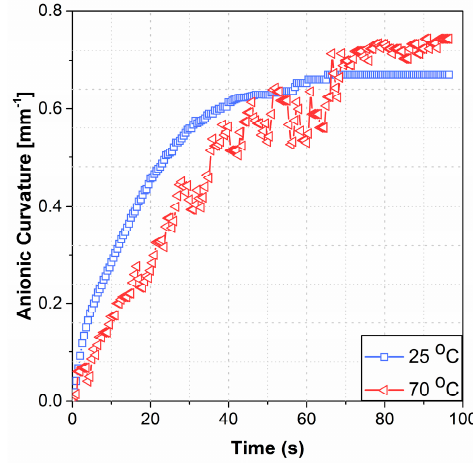
Figure 4. The anionic curvature at 25 °C and 70 °C, both shifted to time = zero for comparison.